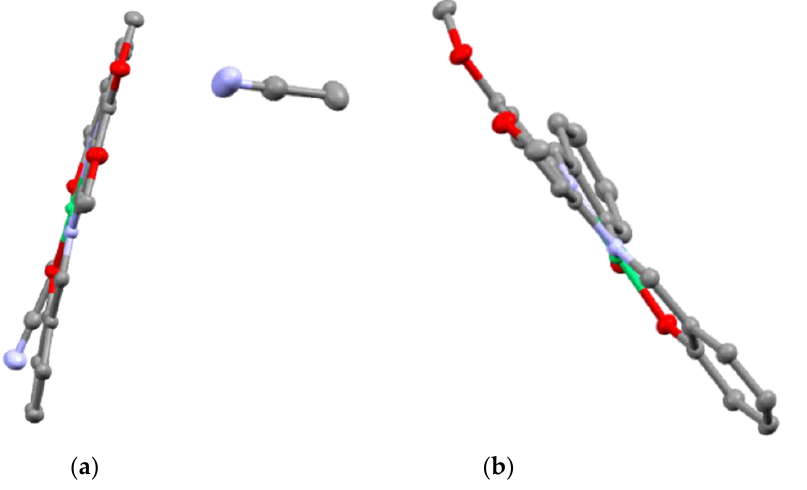
Figure 2. Comparison of the distortion of structures ( a , b ) with thermal ellipsoids at a 50% probabil- ity.